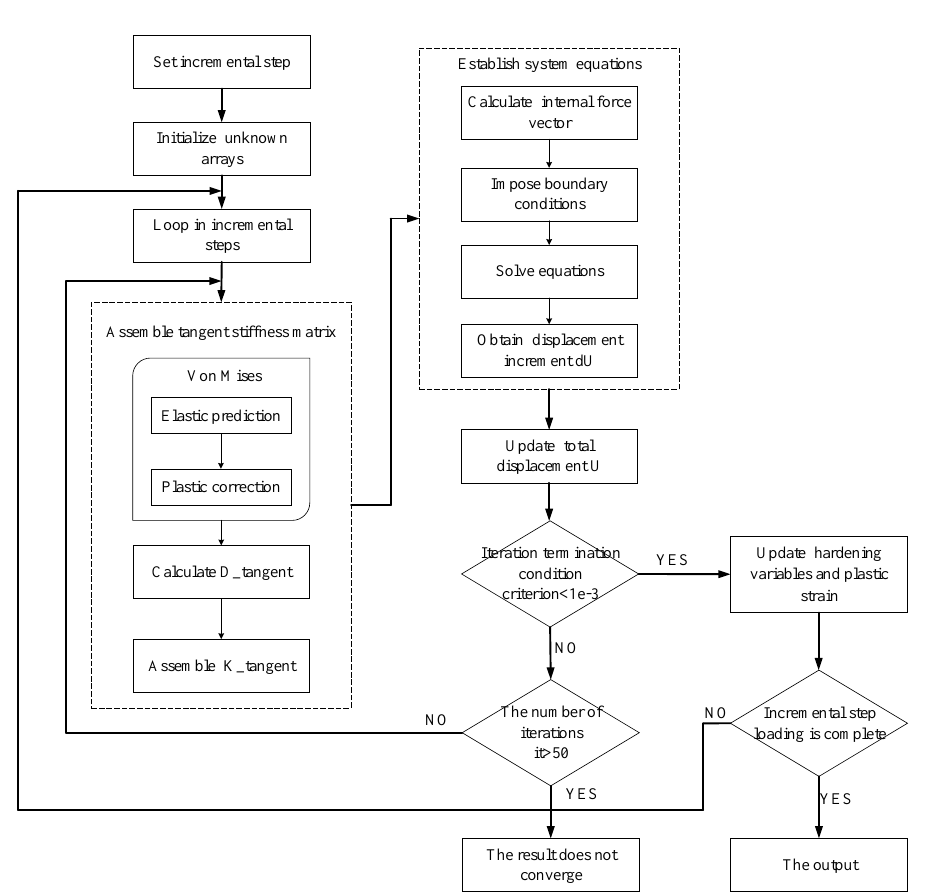
Figure 4. Illustration of the calculation procedure of incremental loading and semismooth Newton method